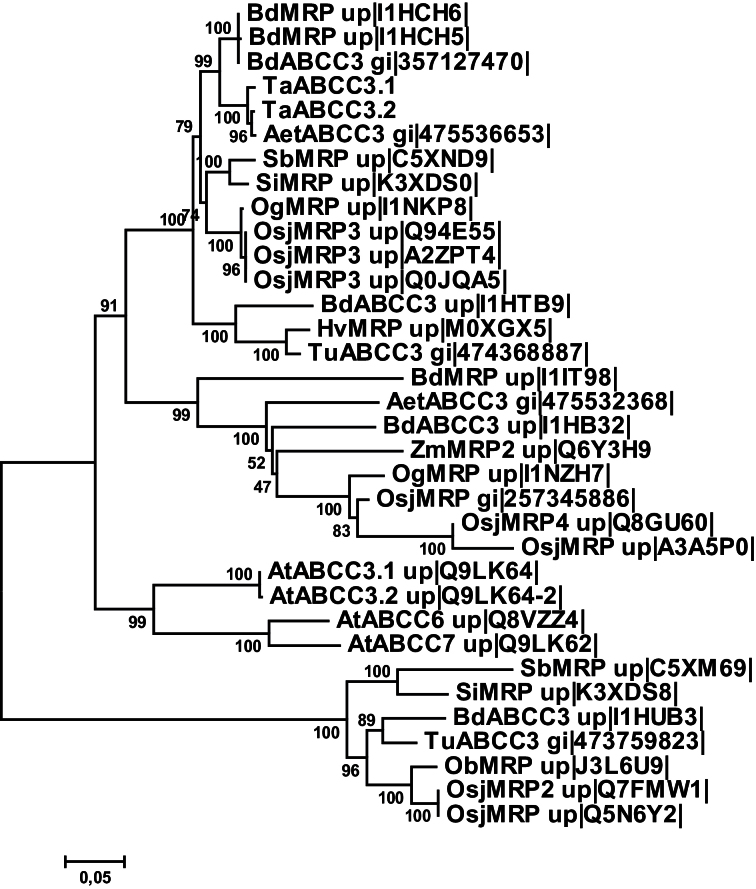
Evolutionary relationships of 34 ABCC-type ABC transporters, representing subclade IIA of plant clade II ABCC transporters. A phylogenetic dendrogram was generated in MEGA4 (Tamura et al., 2007), after calculation of Dayhoff evolutionary distance matrix, bootstrap values (1000 replicates), and an unrooted neighbour-joining tree from a multiple protein alignment generated with the NCBI Cobalt tool (Papadopoulos and Agarwala, 2007). Bootstrap values are shown next to branches and depict the percentage of replicate trees in which the associated proteins clustered together in the bootstrap test (1000 replicates). For bootstrap values of <50, branches are collapsed. The tree is drawn to scale, i.e. branch lengths correlate directly with the Dayhoff evolutionary distances used to infer the phylogenetic tree. Species names were abbreviated as follows: Aet- Aegilops tauschii (Tausch’s goatgrass); At, Arabidopsis thaliana (mouse-ear cress); Bd, Brachypodium distachyon (purple false brome); Hv, Hordeum vulgare subsp. vulgare (barley); Ob, Oryza brachyantha; Og, Oryza glaberrima (African rice); Osj, Oryza sativa Japonica group (rice); Sb, Sorghum bicolor (sorghum); Si, Setaria italica (foxtail millet); Ta, Triticum aestivum (wheat); Tu, Triticum urartu; Zm, Zea mays (corn). Proteins were abbreviated either as ABCC (ABC transporter C family protein) or MRP (multidrug resistance-associated protein ABC transporter), with ABCC reflecting a more accurate annotation status. Except for the two newly described TaABCC3 proteins, all protein abbreviations are followed by their respective protein identifiers in the UniProtKB (up) (The UniProt Consortium, 2012) or GenBank (gi) (Benson et al., 2013) database.